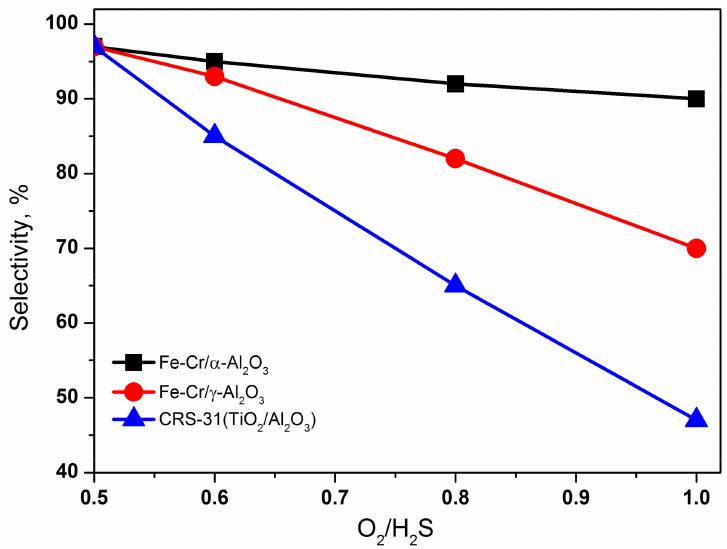
Figure 7. The dependence of the selectivity of the process of direct H 2 S oxidation on the ratio O 2 /H 2 S in the initial mixture (adapted from